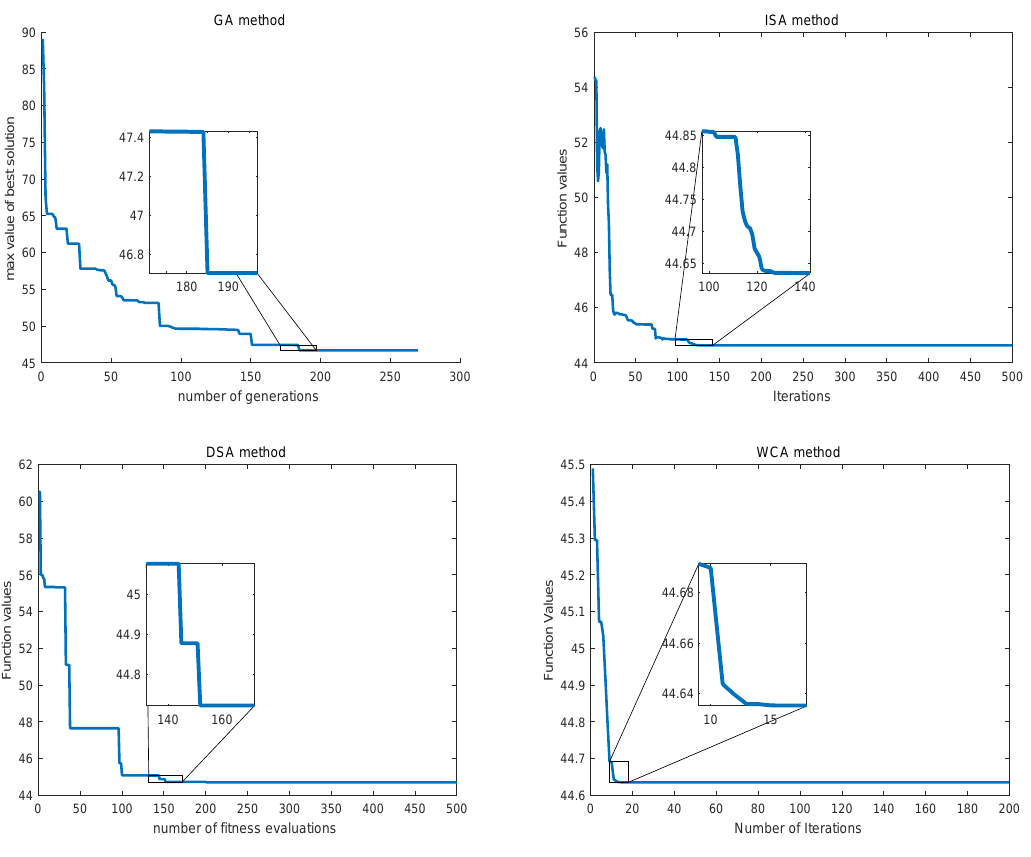
Figure 9. The generation cost at time 12